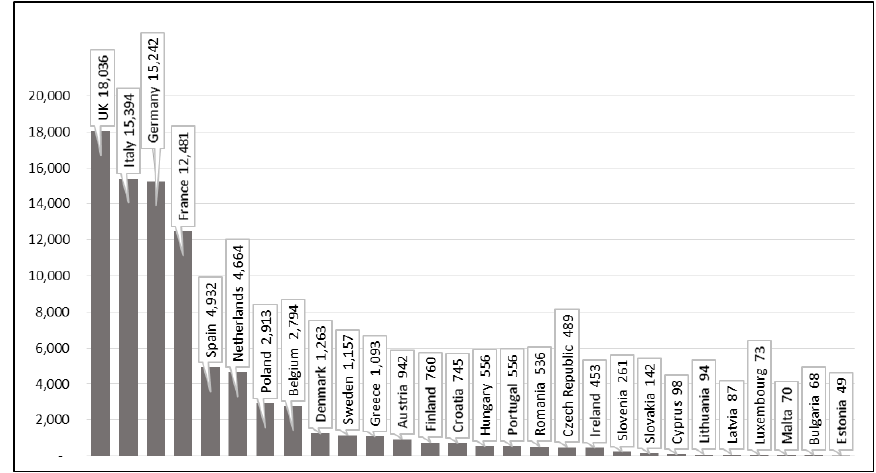
Figure 5. Asbestos cancer deaths at work in EU28 [6]